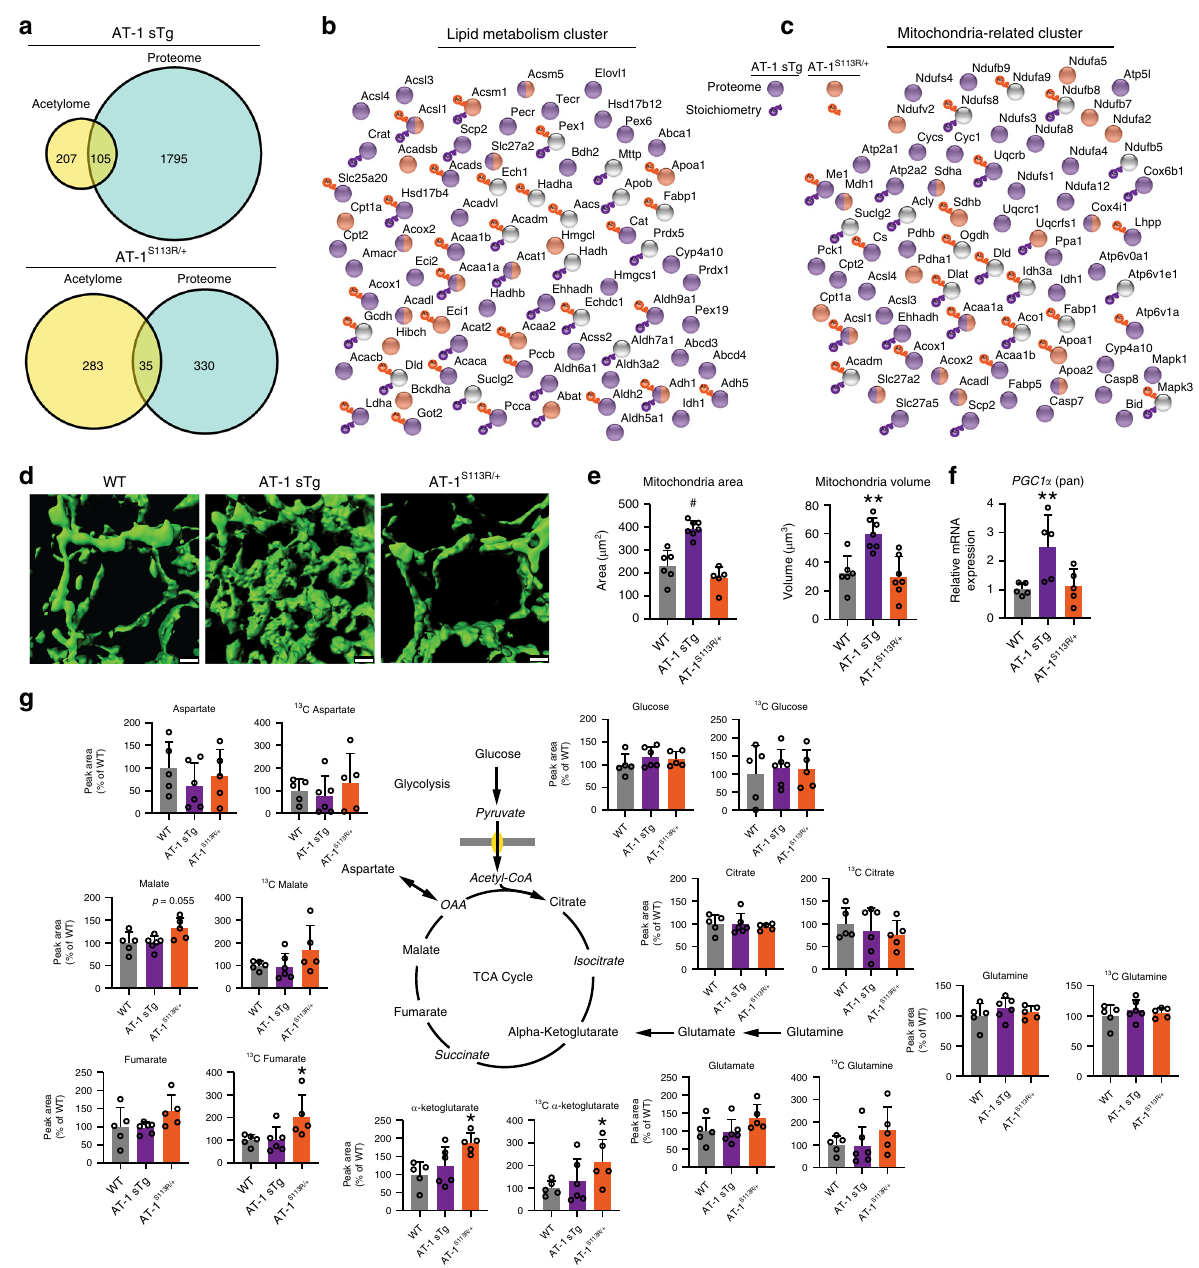
Fig. 4 AT-1 sTg and AT-1 S113R/ + mice show signi fi cant metabolic and mitochondria adaptation. a Venn diagram of overlapping signi fi cant proteins found to be modi fi ed in their expression levels (proteome) and in their stoichiometry of lysine acetylation (acetylome) within AT-1 sTg (upper) and AT-1 S113R/ + (lower) livers. b , c Proteins found to be enriched in lipid metabolism ( b ) and mitochondria-related ( c ) KEGG pathways are shown in clusters according to their level of regulation. Changes in the stoichiometry of acetylation are indicated by a purple (AT-1 sTg) or orange (AT-1 S113R/ + ) acetyl group; changes in the proteome are indicated by a purple (AT-1 sTg) or orange (AT-1 S113R/ + ) circle; no change in proteome level is indicated by a gray circle. d , e Mitochondria morphology in primary-cultured hepatocytes was examined with CellLight mitochondria stain (scale bar, 1 µ m) ( d ) and quanti fi ed using Imaris reconstruction of area and volume ( e ) (hepatocytes from biologically independent animals; WT, n = 6; AT-1 sTg, n = 7 ; AT-1 S113R/ + , n = 7). One- tailed Student's t test. ** P < 0.005; # P <0.0005. f mRNA levels of PGC1 α (pan) in liver samples (livers from biologically independent animals; WT, n = 5; AT-1 sTg, n = 5; AT-1 S113R/ + , n = 5). One-tailed Student's t test. ** P < 0.005. g Primary cultured hepatocytes were labeled with 13 C-glutamine for 30 min before collection. The total TCA intermediate metabolite levels and 13 C-labeled metabolite levels are shown (hepatocytes from biologically independent animals; WT, n = 5; AT-1 sTg, n = 6; AT-1 S113R/ + , n = 5). Two-tailed Student ’ s t test. * P < 0.05. All data are represented as mean ±